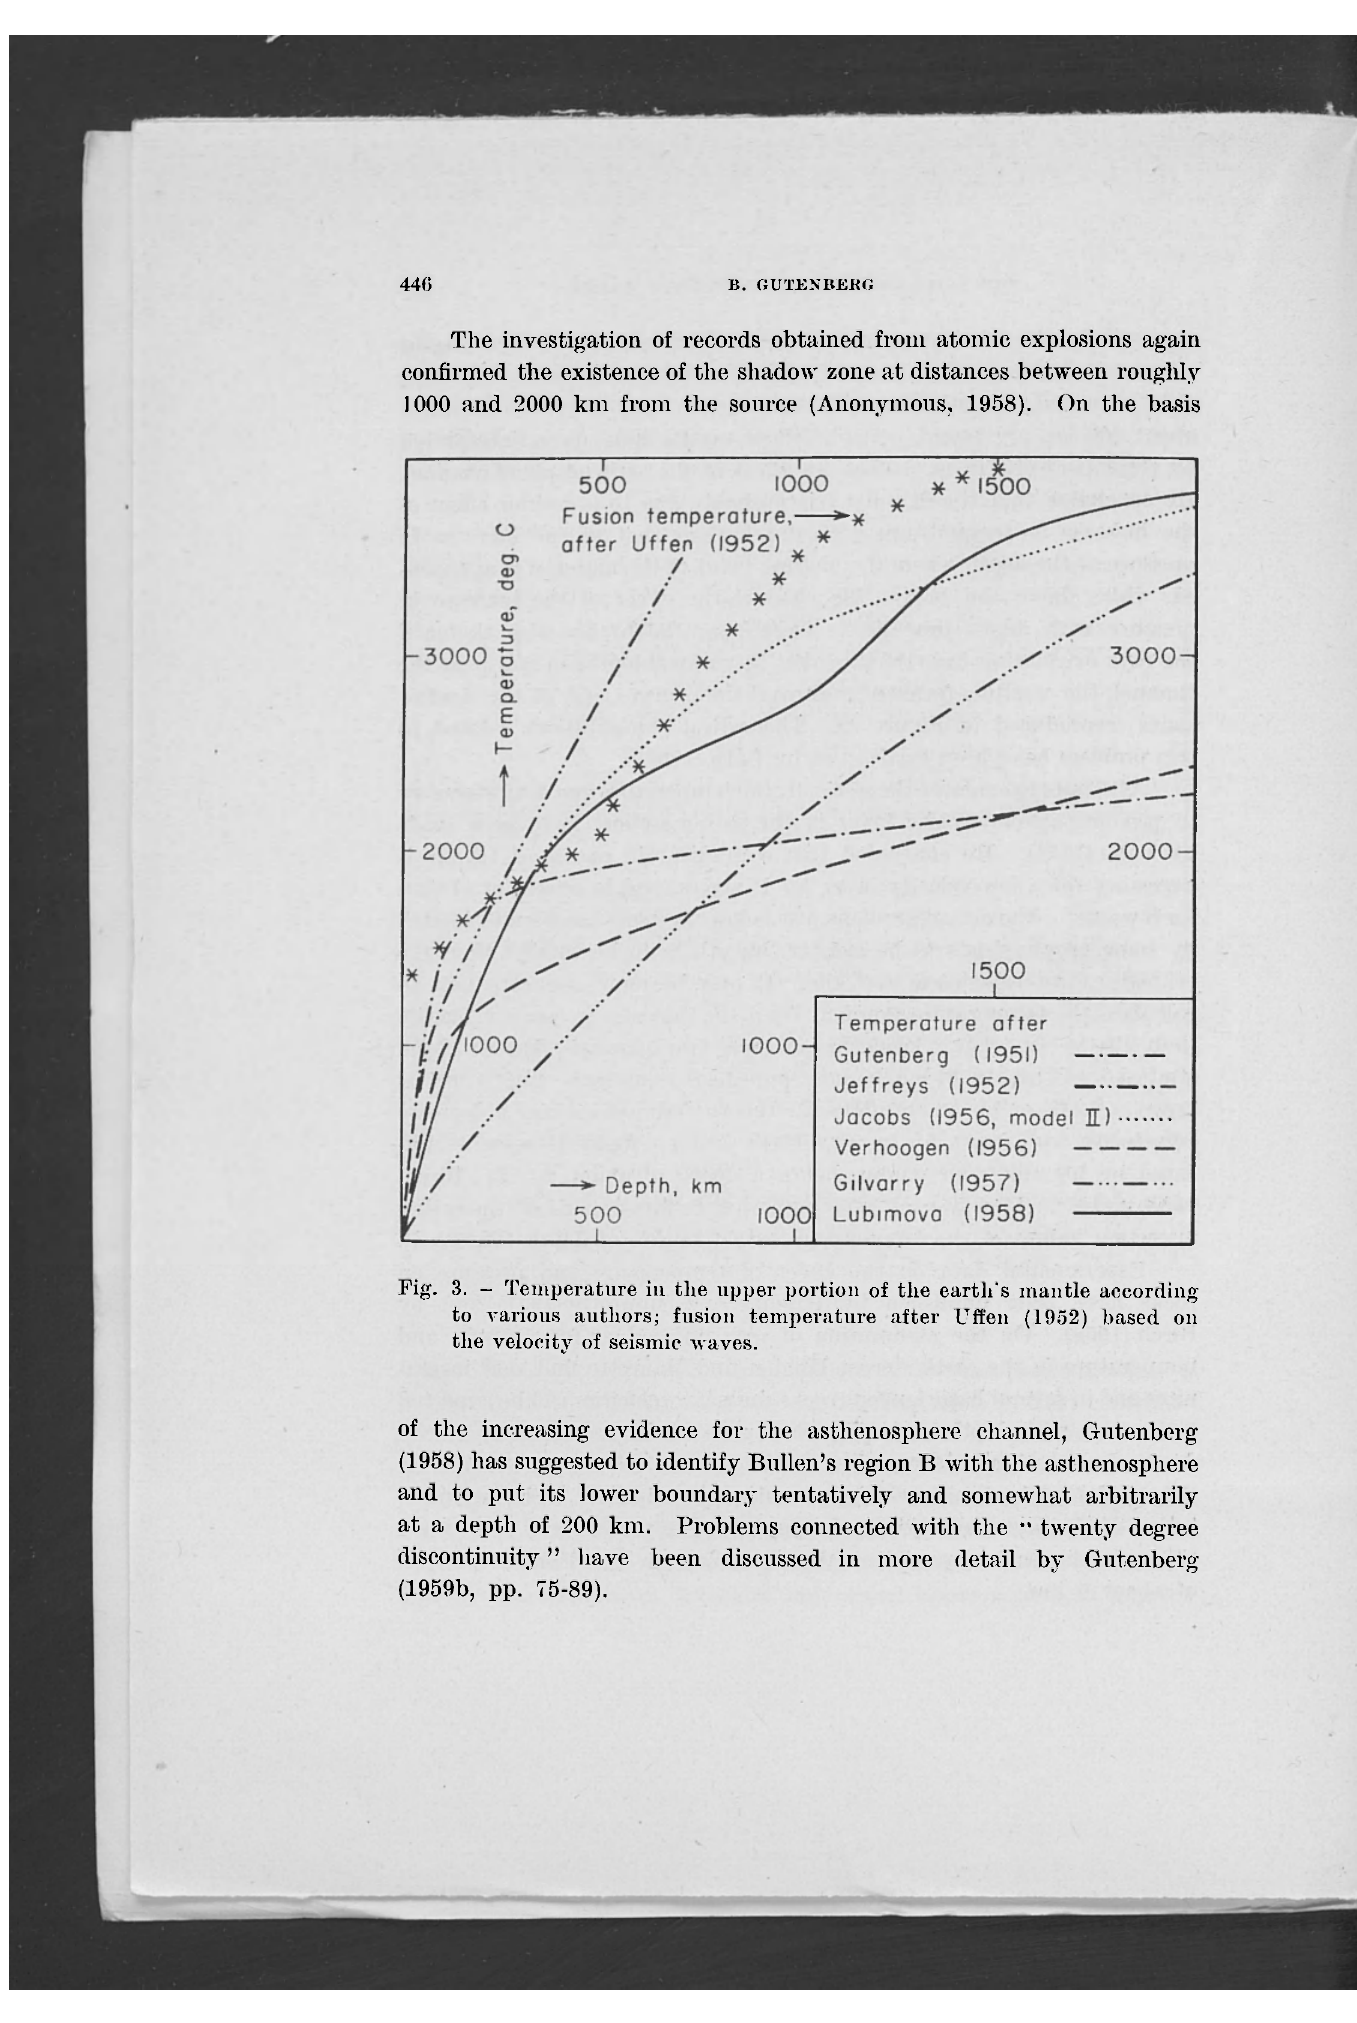
(1958) has suggested to identify Bullen's region B with the asthenosphere and to put its lower boundary tentatively and somewhat arbitrarily at a depth of 200